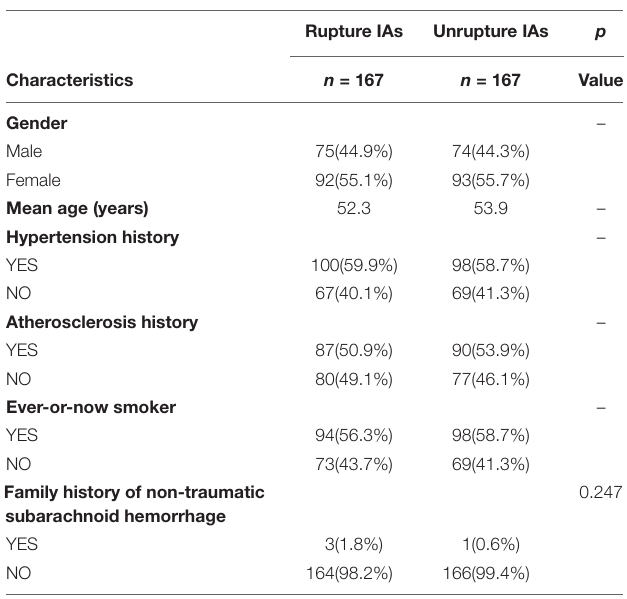
cut-off value. The results are presented in 95% confidence TABLE 1 | Demography